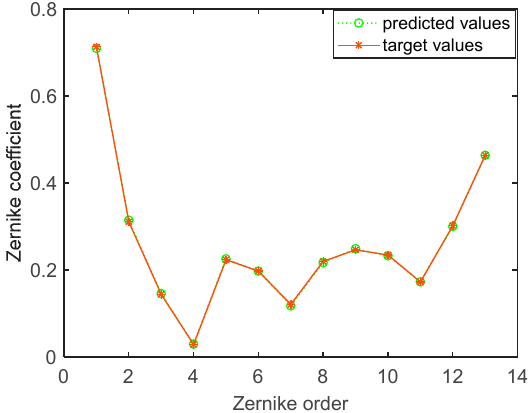
Figure 7. The predicted result of the ELM model.